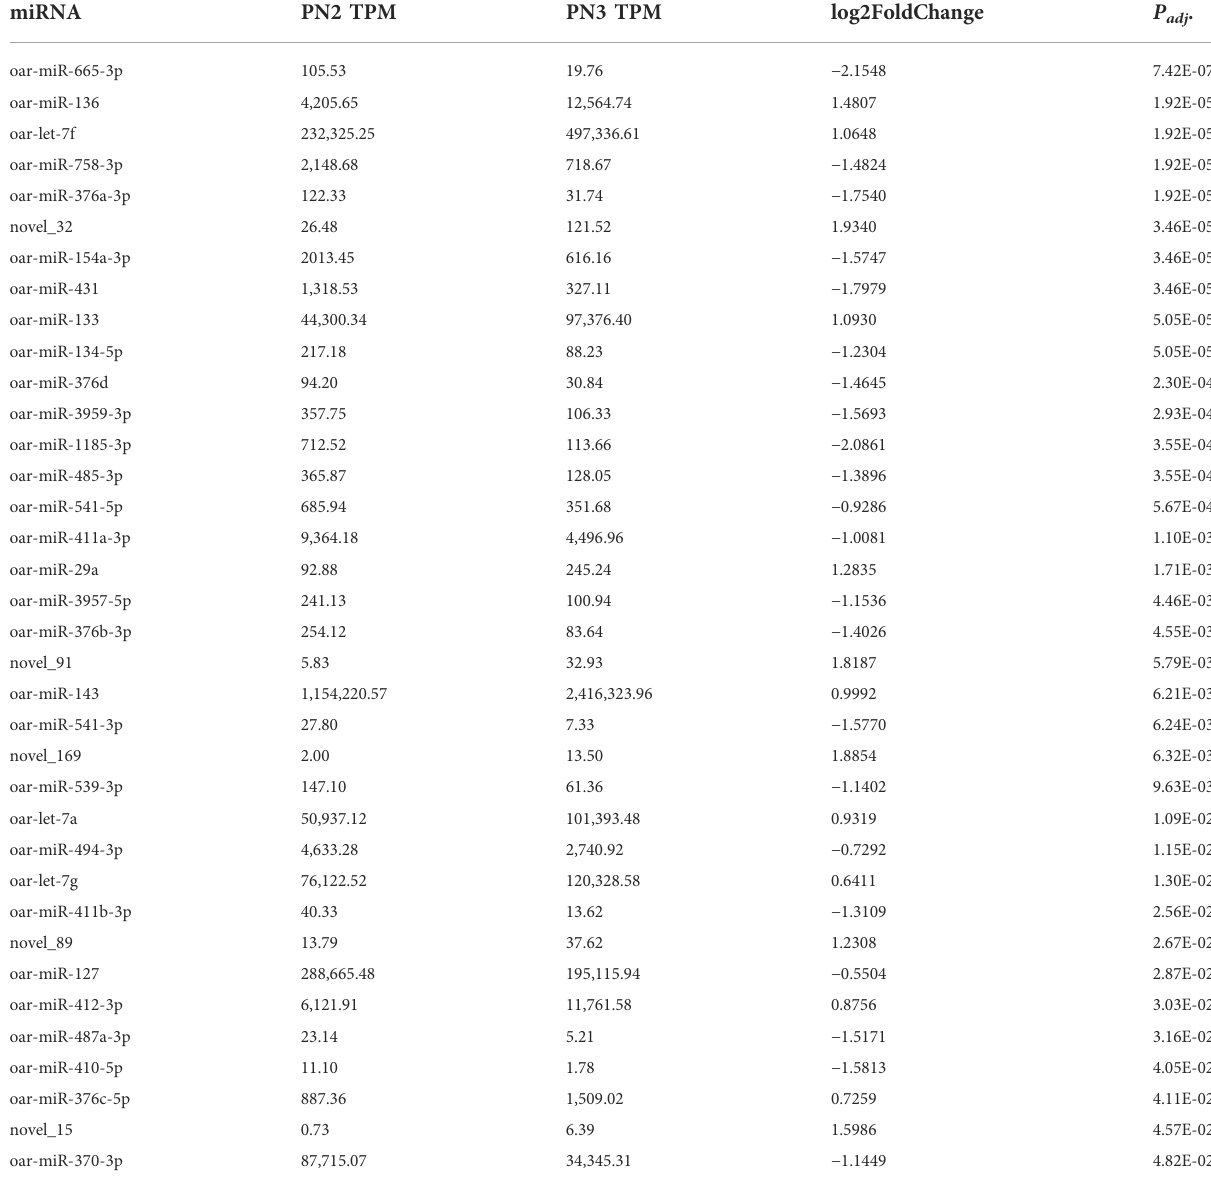
TABLE 3 Differentially expressed miRNA during mid prenatal phase (PN2 = gd110; PN3 = gd133) by signi fi cance level. miRNA PN2 TPM PN3 TPM log2FoldChange P adj